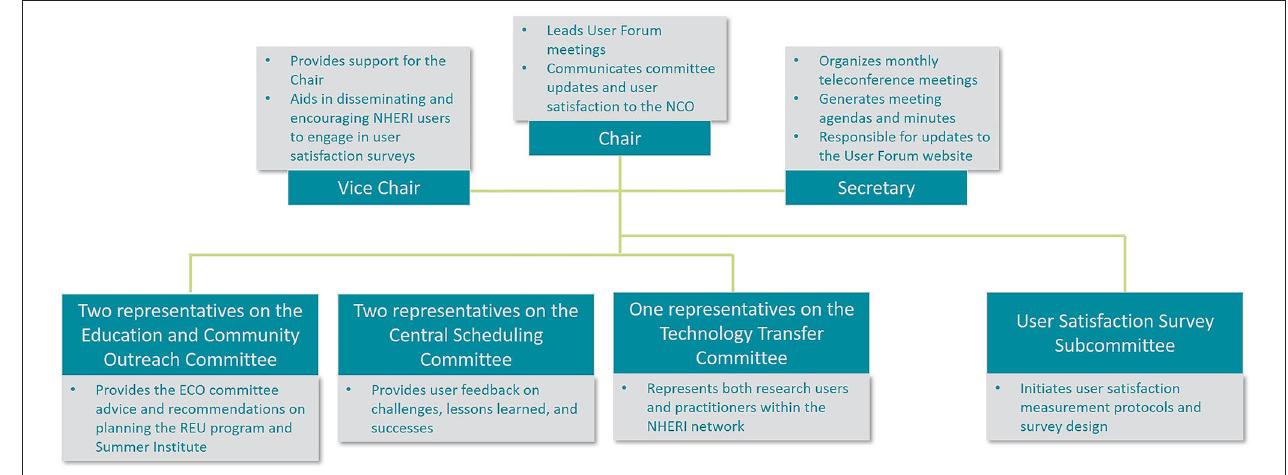
FIGURE 2 | User forum member roles and